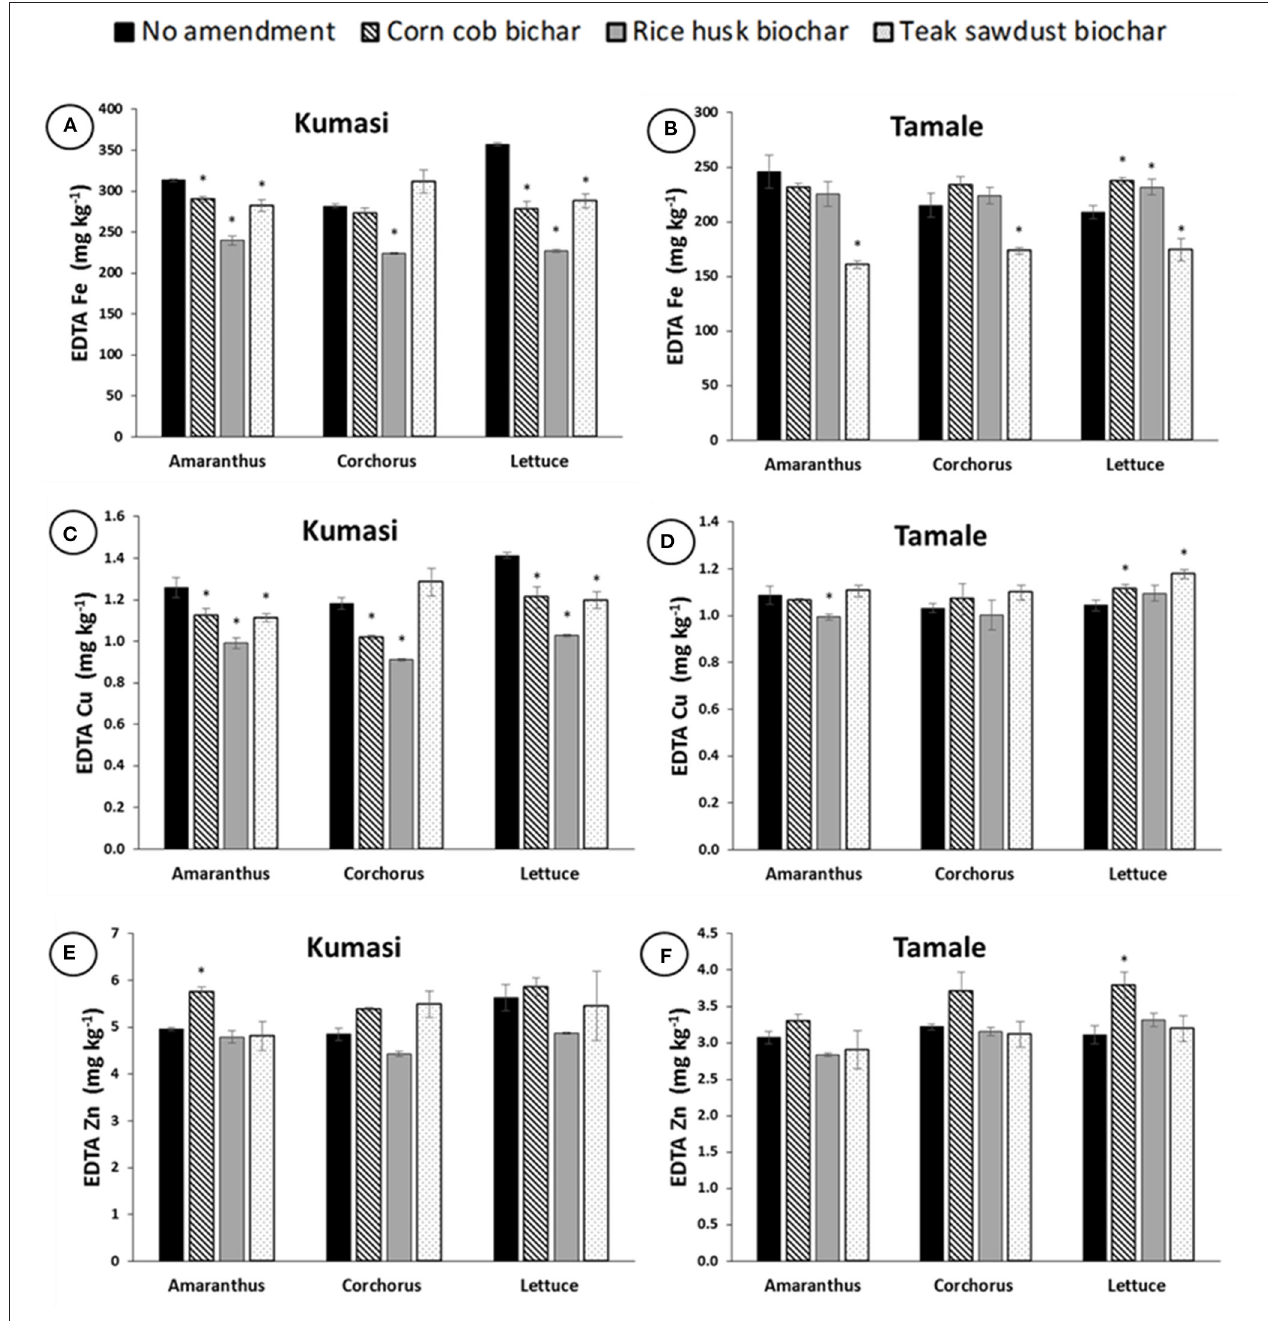
FIGURE 3 | Fe, Cu, and Zn concentrations in EDTA extracts of Kumasi (A,C,E) and Tamale (B,D,F) soils planted with Amaranth, Corchorus and Lettuce and amended with 5% (w/w) corn cob biochar, rice husk biochar, or teak sawdust biochar. Data with asterisks are statistically significantly different from control for each crop ( p < 0.05). Error bars represent standard deviation n =